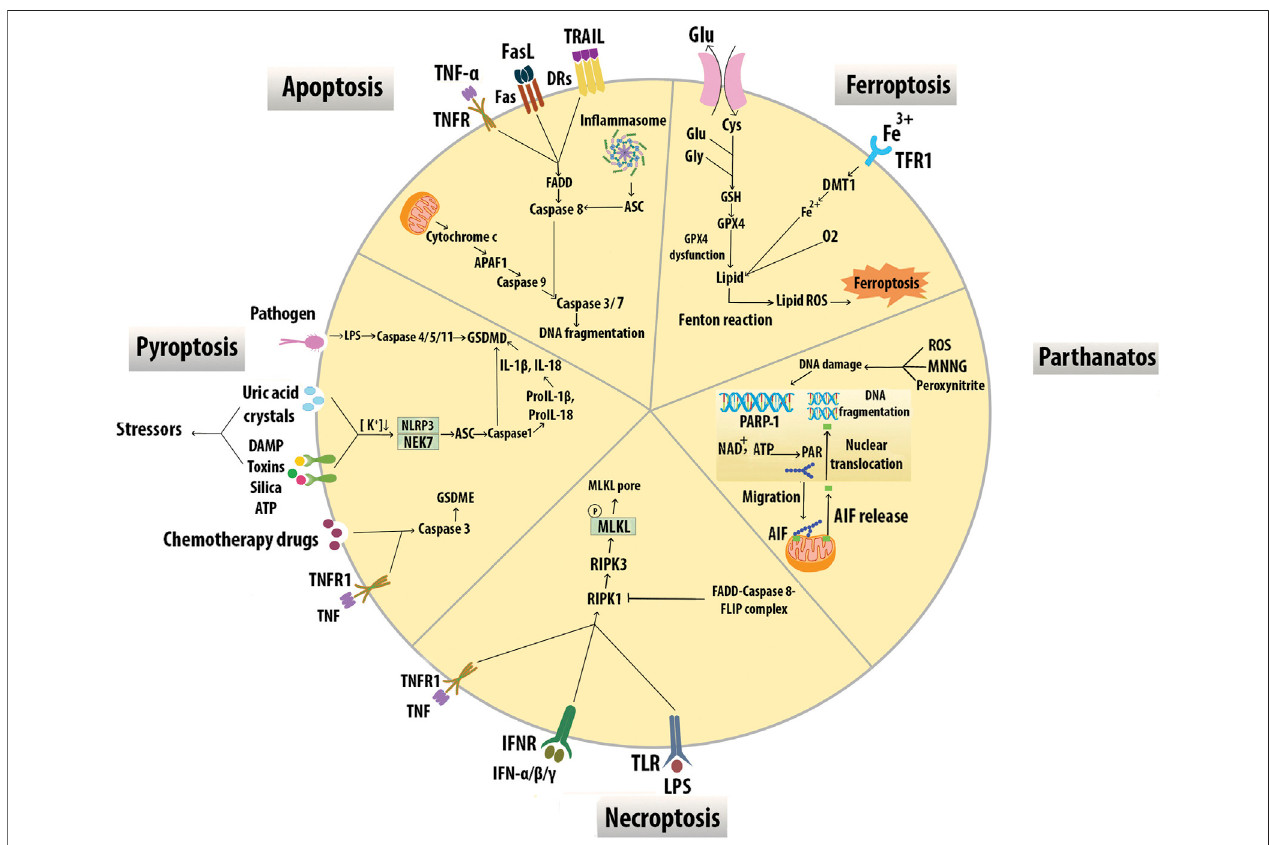
FIGURE 7 | Modes of macrophage death. Different modes of cell death including apoptosis, pyroptosis, necroptosis, parthanatos, and ferroptosis have unique activating stimuli and present different signaling pathways and distinct physiological outcomes. Inhibitors of the divalent metal transporter 1 (DMT1).